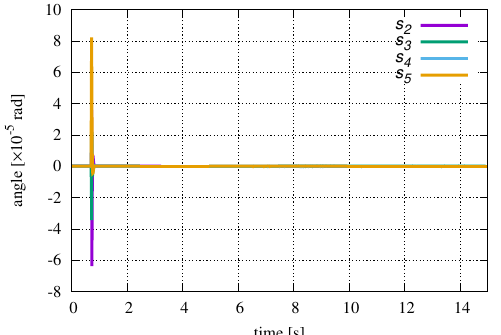
Figure 32. Case 3: Time variation of estimation error of the twist angle of the springs.